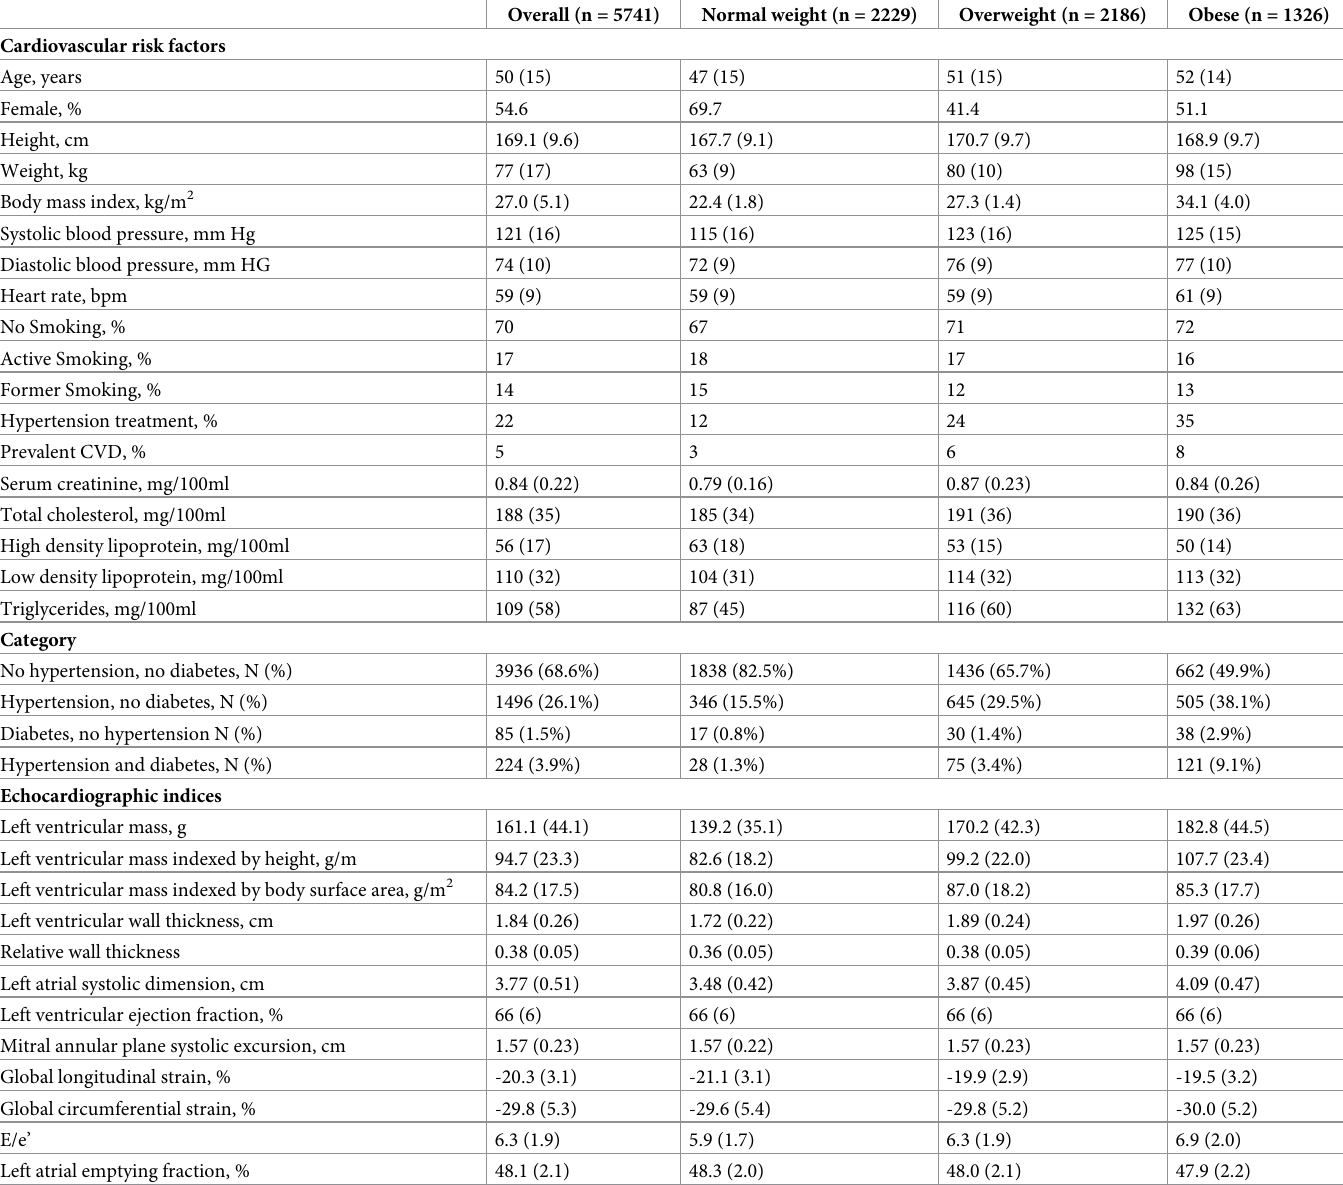
Table 1. Baseline characteristics of study sample, stratified by BMI